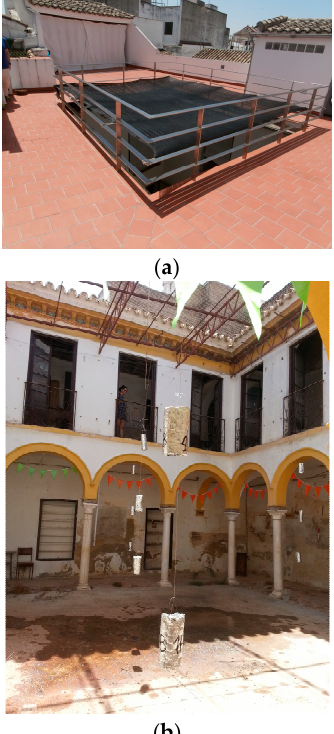
Figure 1. Images of the courtyards. ( a ) Canvas cover installed in the courtyard A. ( b ) Arcade of courtyard